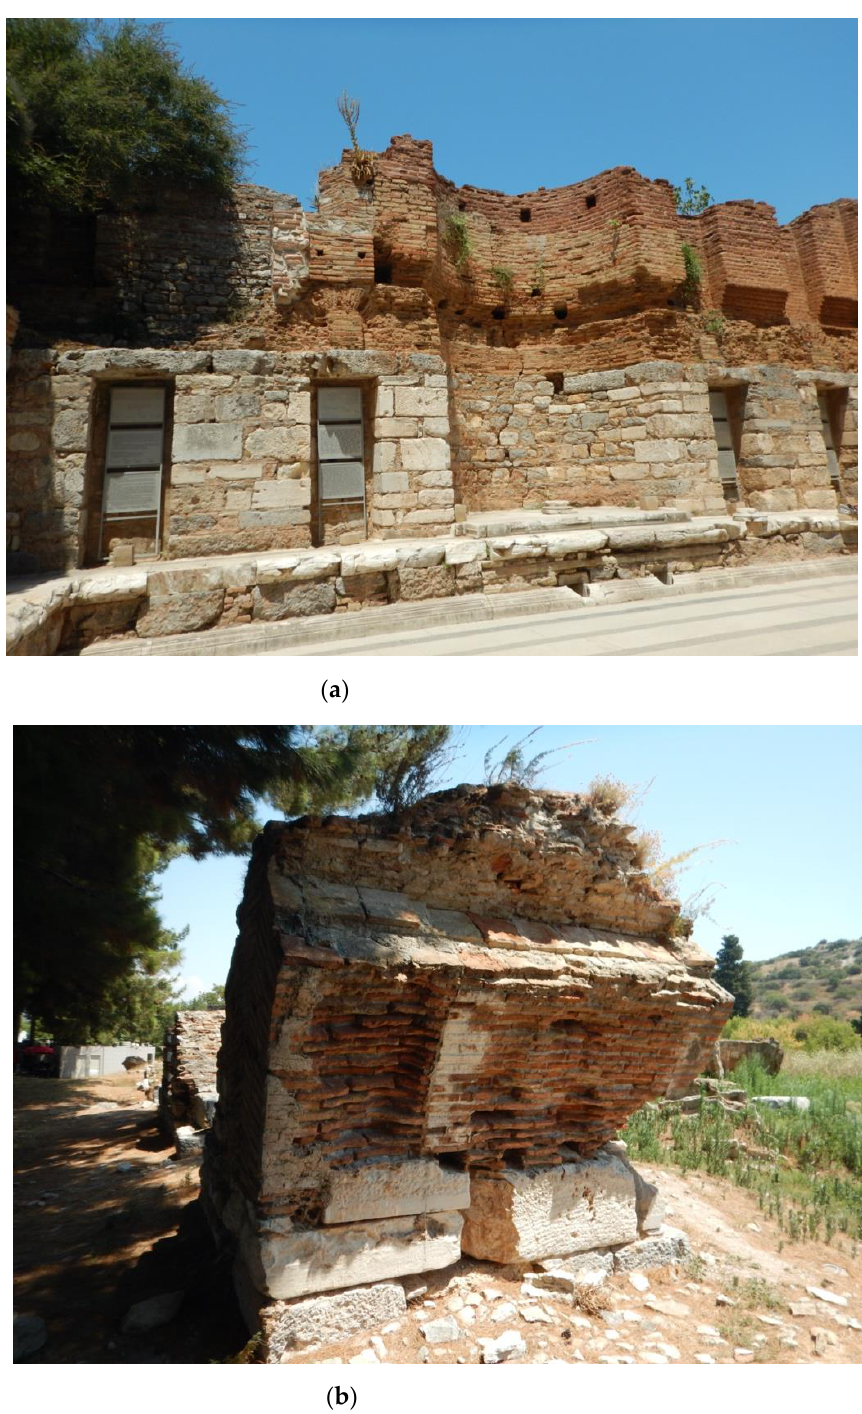
Figure 1. Fragments of brickwork on lime mortar in Chersonesos (Crimea): ( a ) The undestroyed part of the brickwork; ( b ) Destroyed part of brickwork.